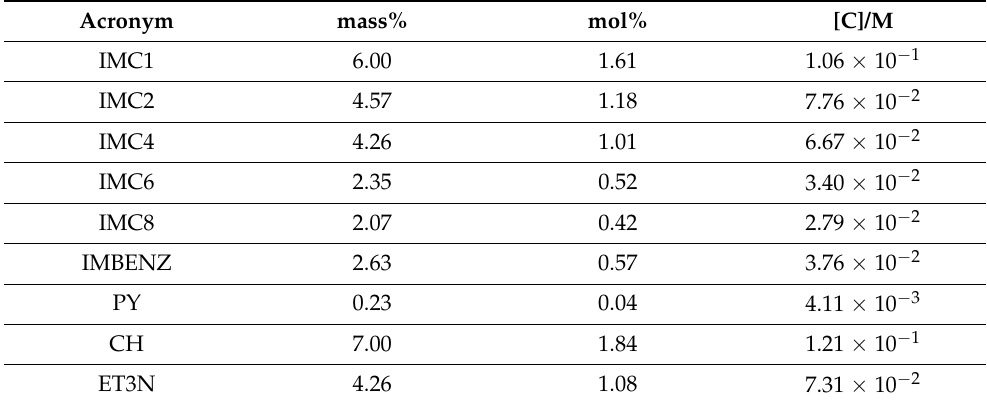
Table 2. Maximum solubility, in mass percentage (mass%), mol percentage (mol%) and molar concentration (M), of GDILs in [C 2